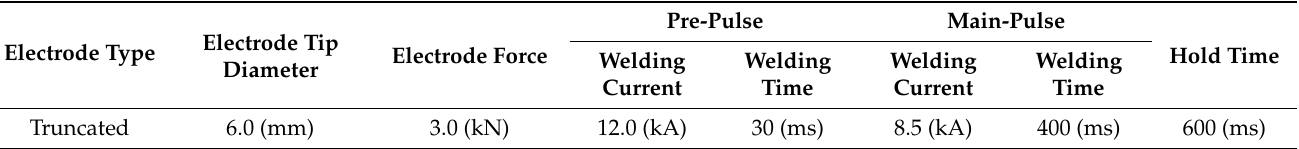
Figure 11. Fitting of the axisymmetric inherent deformation modes.